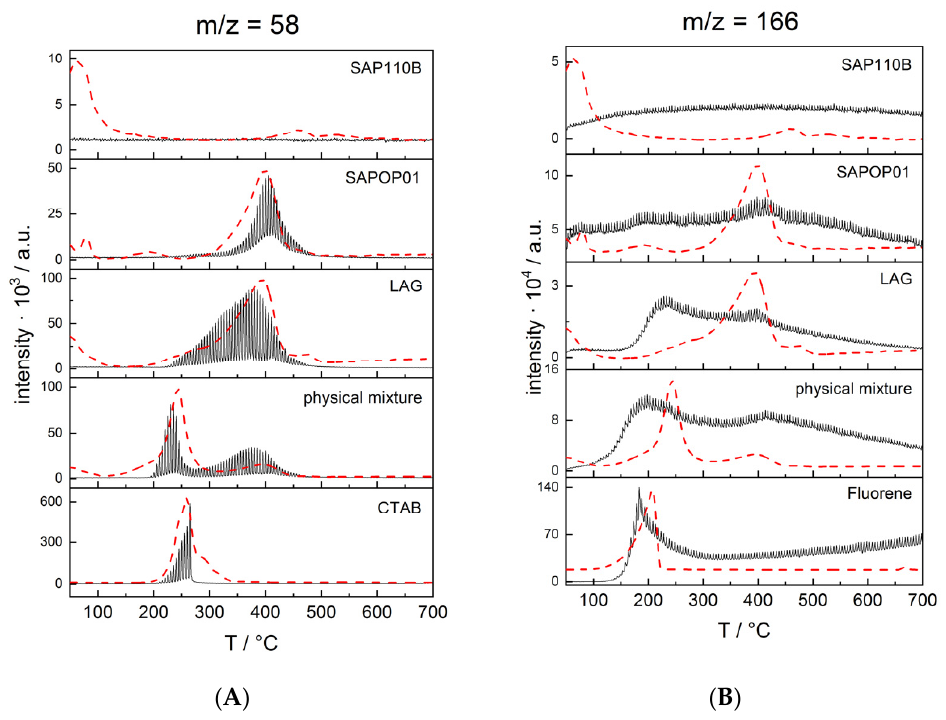
Figure 7. Evolution profiles of the signals at 95 m / z ( A ) and 166 m/z ( B ) recorded in the analyses of the pure samples (CTABr, Fluorene and Na-SAP110) and of the hybrid materials (CTA_FL_SAP_LAG and CTA_Sap_LAG). For comparison, the respective dTA curves are reported in dotted lines .